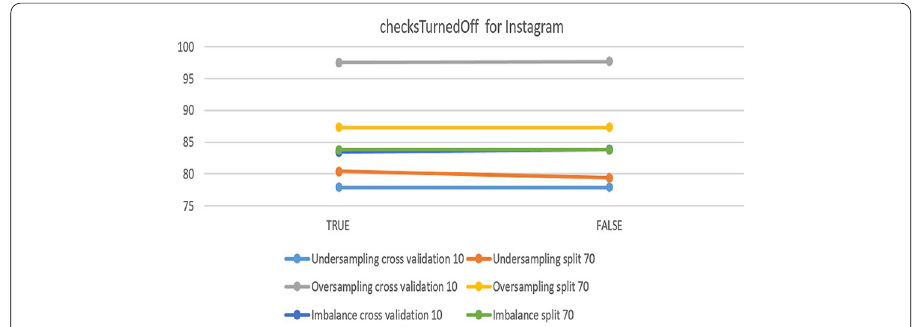
Fig. 19 The accuracy of checksTurnedOff for SVM in Instagram